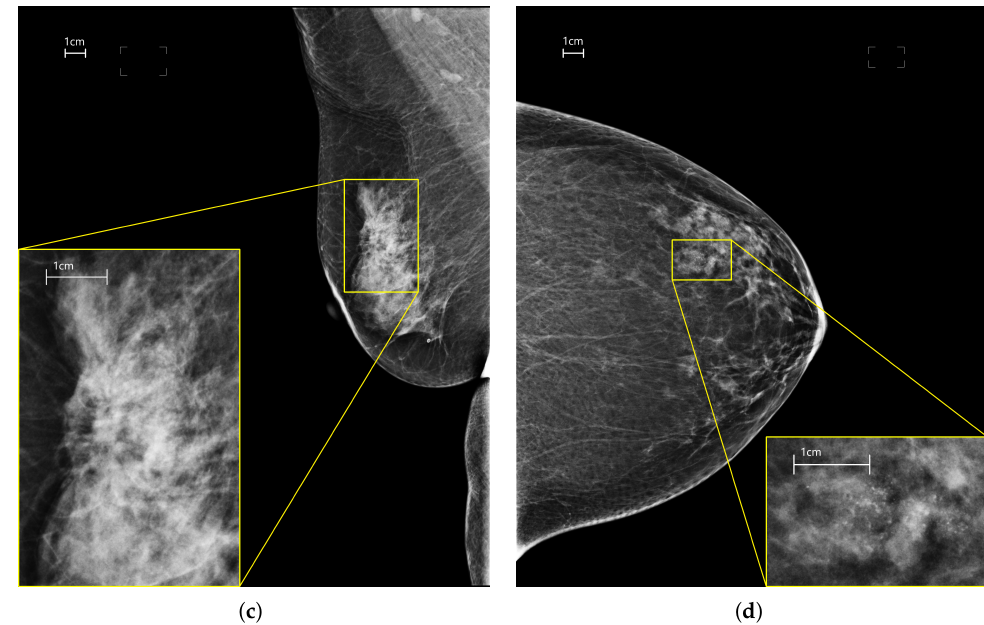
Figure 1. Mammograms of different views, laterality and containing different lesions. ( a ) right cranio-caudal with two lesions: a calcification cluster and a mass. ( b ) left medio-lateral oblique with a focal asimmetry. ( c ) right medio-lateral oblique with an architectural distorsion. ( d ) left cranio-caudal containing a mass with calcifications